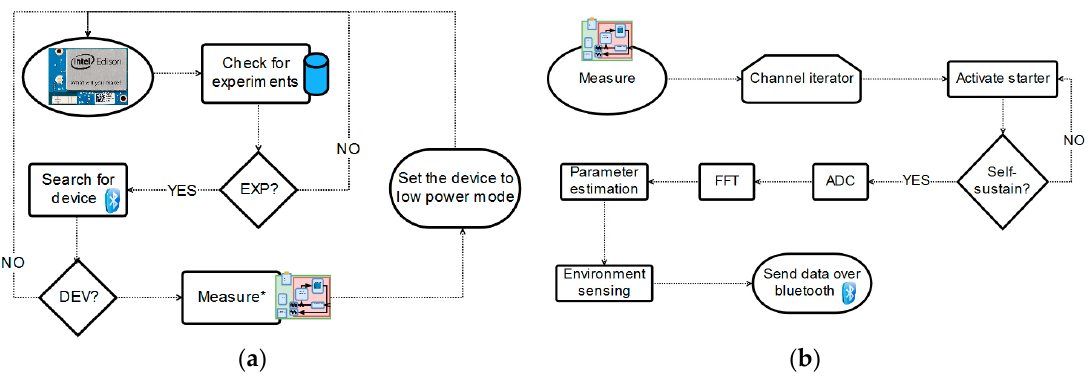
Figure 7. Flow diagram for ( a ) the measurement protocol ( b ) the microcontroller measurement process. EXP = experiment. DEV = device.